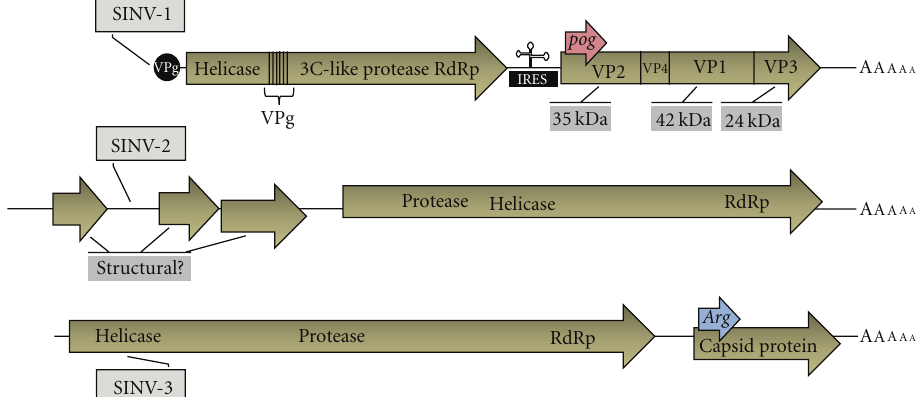
Figure 2: Comparative genome architecture of SINV-1, SINV-2, and SINV-3. Orientation of each genome is 5 (cid:2) to 3 (cid:2) (left to right). Relative positions of non-structural and structural proteins are indicated within each open reading frame (rectangles). ORFs are illustrated in di ff erent vertical positions to show their in-frame, comparative relationships. The SINV-1 genome is monopartite, dicistronic, and possesses 6 copies of the viral protein genome (VPg) peptide, an intergenic IRES, a predicted overlapping gene ( pog ) within ORF 2, and well- characterized capsid proteins (VPs) of known mass. The SINV-2 genome is monopartite with non-structural proteins encoded by the 3 (cid:2) - proximal ORF. The 3 small ORFs at the 5 (cid:2) -proximal end of the genome are presumed capsid proteins. The SINV-3 genome is monopartite with non-structural proteins encoded by ORF 1 (5 (cid:2) -proximal) and capsid proteins by ORF 2 (3 (cid:2) -proximal). An overlapping ORF ( Arg ) was identified within ORF 2 of a virus isolate from infected S. invicta ants from